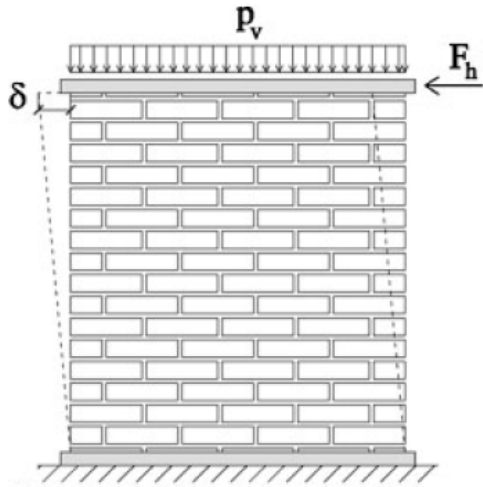
Figure 16. Shear test of brick panel (Vermeltfoort and Raijmakers [45]).